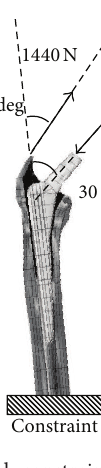
Figure 2: Loading and constraint conditions of FE model. A resultant force of 1,800N was applied to the head at an angle of 30 ∘ along the long axis. An abductor force of 1,440 N was applied from the greater trochanter along the long axis at an angle of 20 ∘ . Hatched squares represent restrained